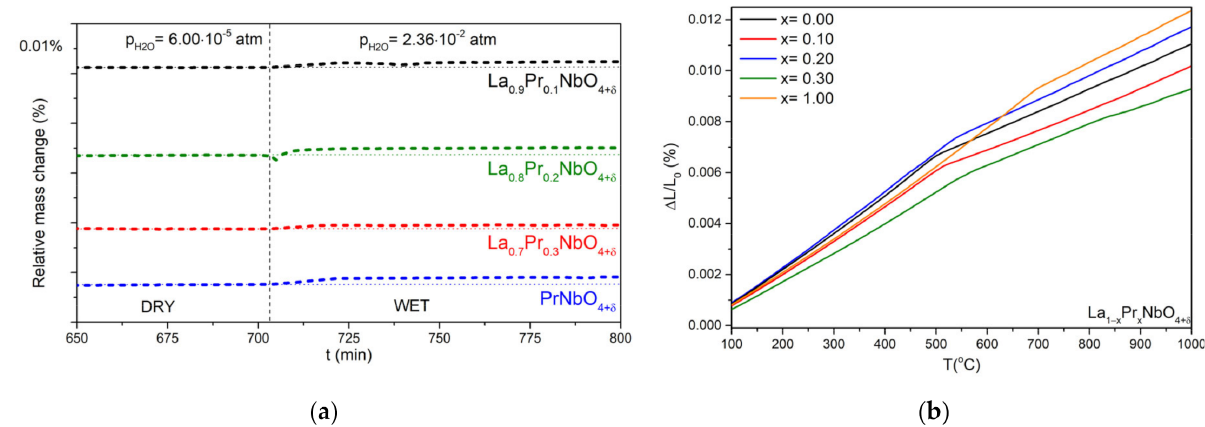
Figure 6. ( a ) Relative mass change observed for La 0.9 Pr 0.1 NbO 4+ δ , La 0.8 Pr 0.2 NbO 4+ δ , La 0.7 Pr 0.3 NbO 4+ δ and PrNbO 4+ δ at 300 ◦ C upon a change of the atmosphere from dry to humidified air; ( b ) Relative elon- gation of a sample as a function of temperature for LaNbO 4+ δ , La 0.9 Pr 0.1 NbO 4+ δ , La 0.8 Pr 0.2 NbO 4+ δ , La 0.7 Pr 0.3 NbO 4+ δ and PrNbO 4+ δ